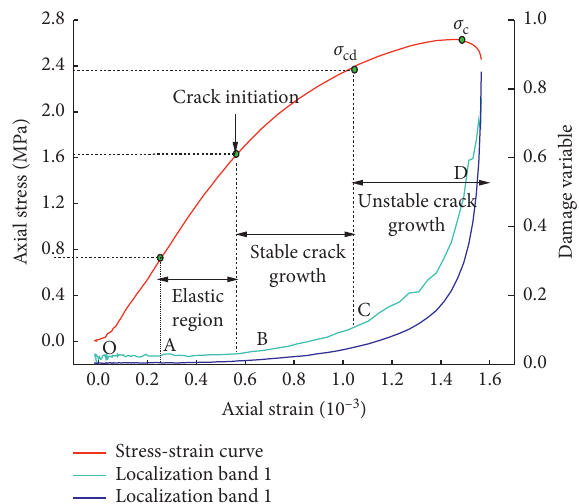
Figure 6: The relationship between whole damage variable and loading curve of sample S